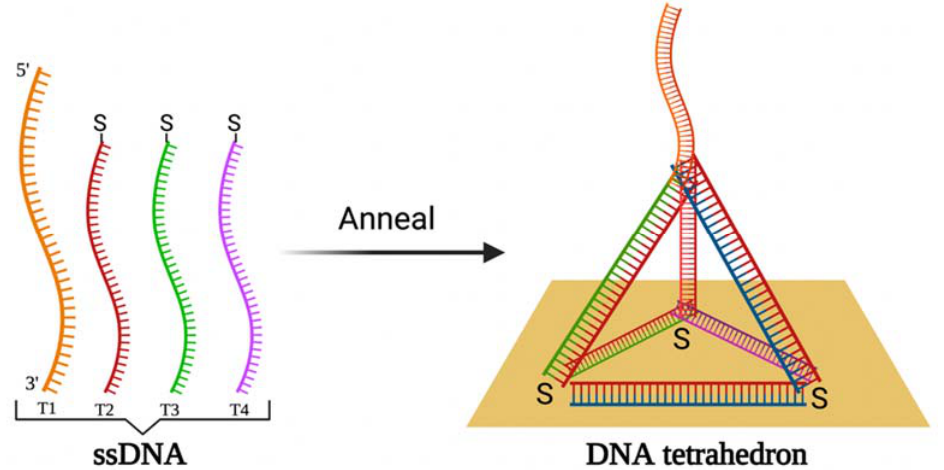
Figure 3. The schematic illustration of DNA tetrahedron formation by annealing of four ssDNA strains followed by the immobilisation DNA tetrahedron on the gold electrode surface.